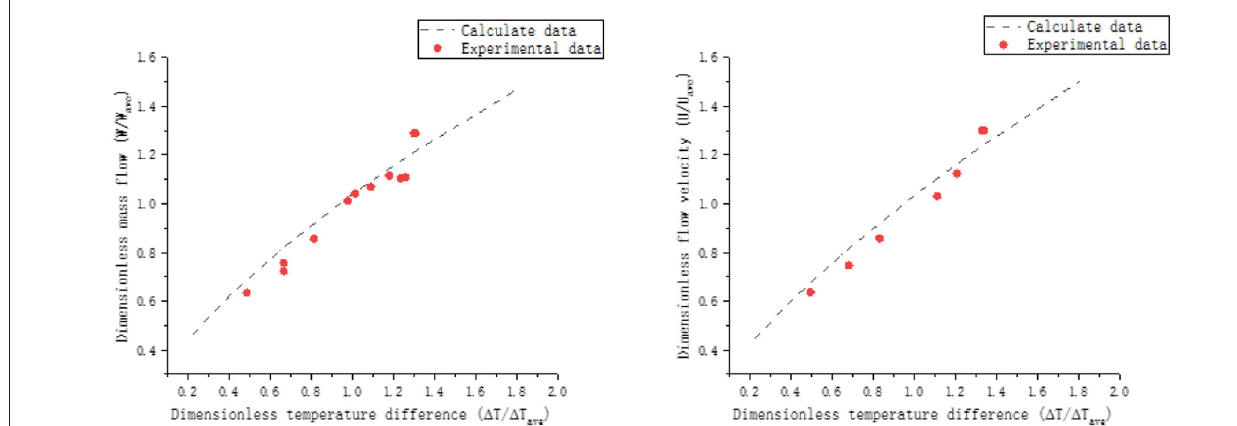
FIGURE 10 | Comparison of experimental and simulation results.